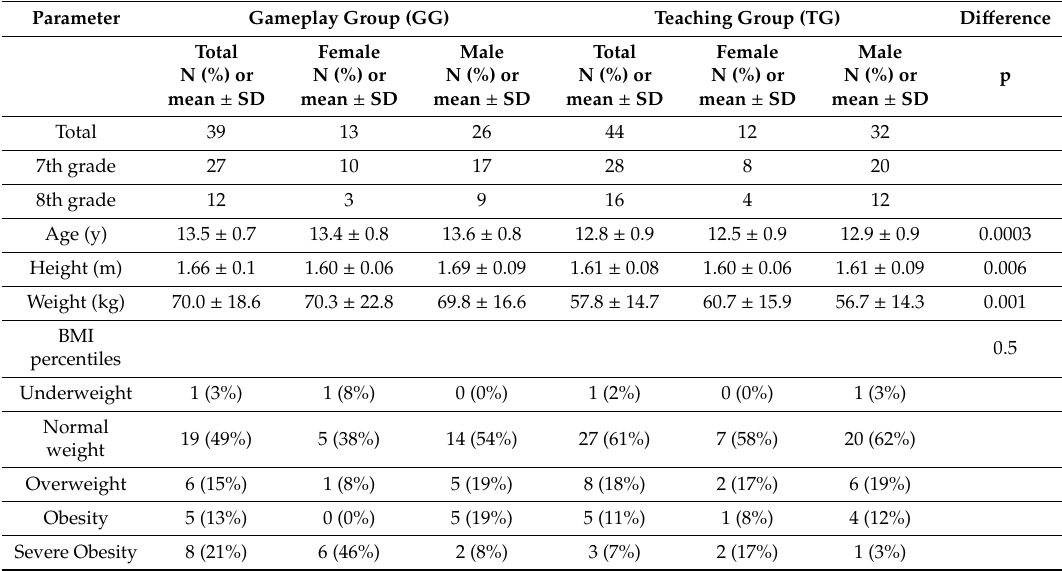
Table 2. Socio-demographic and anthropometric characteristics of intervention groups at baseline.